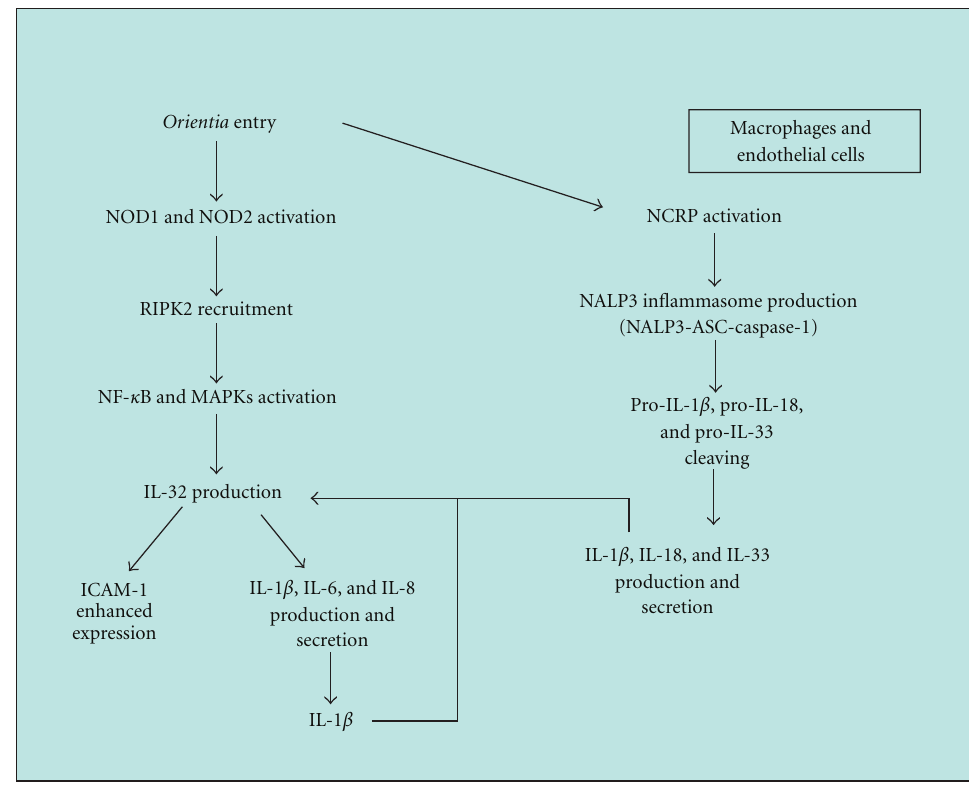
Figure 9: Innate immune system in oriential